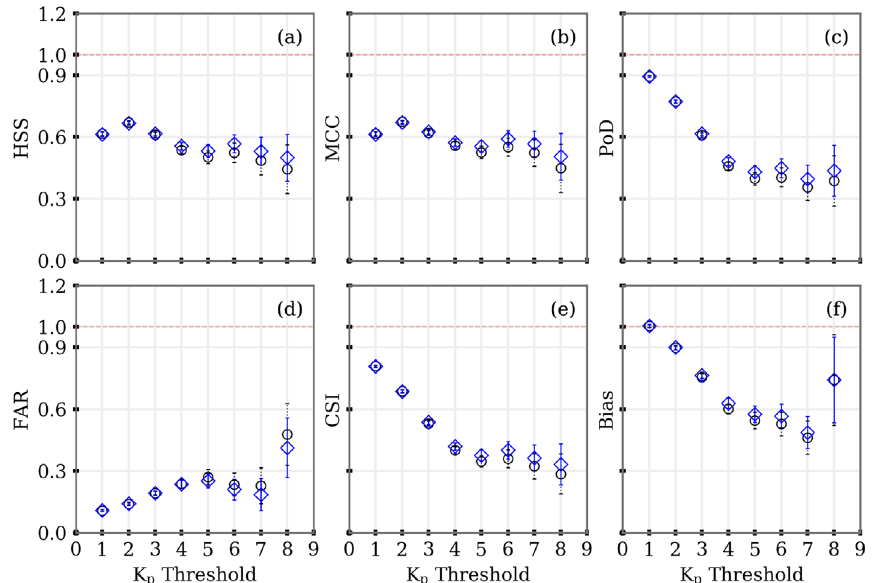
Fig. 12. Different performance metrics (a) HSS, (b) MCC, (c) PoD, (d) FAR, (e) CSI, and (f) Bias comparing the two variants of geomagnetic storm forecasting model at different K p thresholds. Model l OMNI (in black circle) and l OMNI þ (in blue diamonds).